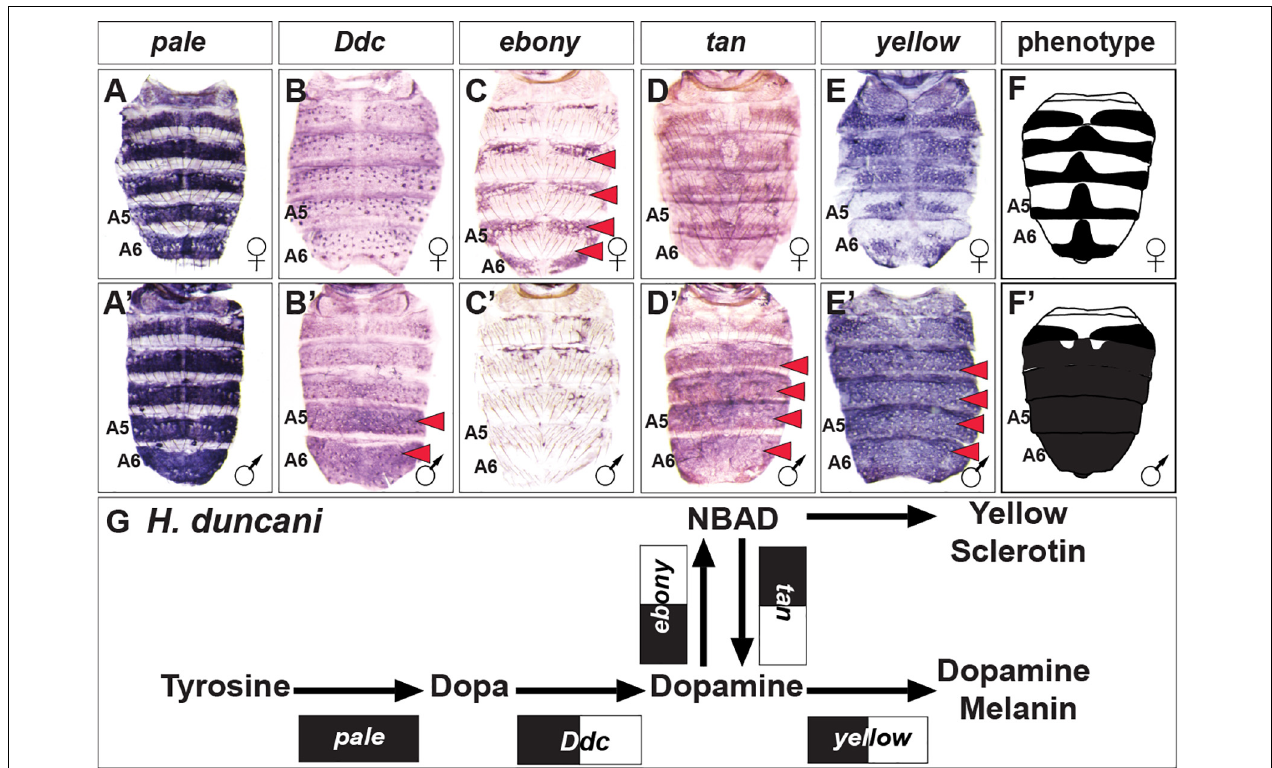
FIGURE 5 | The pigment metabolic pathway utilization for the dimorphic H. duncani . (A–E) Female and (A’–E’) male expressions of H. duncani pigment metabolic pathway genes, and (F,F’) cartoon representation of the pigmentation phenotype. (G) Summary of the H. duncani pathway use includes robust expression of all genes, with dimorphic expressions of Ddc , ebony , tan , and yellow . (A,A’) pale , (B,B’) Ddc , (C,C’) ebony , (D,D’) tan , and (E,E’) yellow . Red arrowheads indicate robust patterns of dimorphic expression in the dorsal abdominal epidermis. (G) Black arrow thickness represents the level of expression for the underlying gene. Monomorphic gene expression is represented by the gene names being placed upon a black rectangle. Dimorphic gene expression is represented by the gene names being placed upon a black and white colored rectangle.